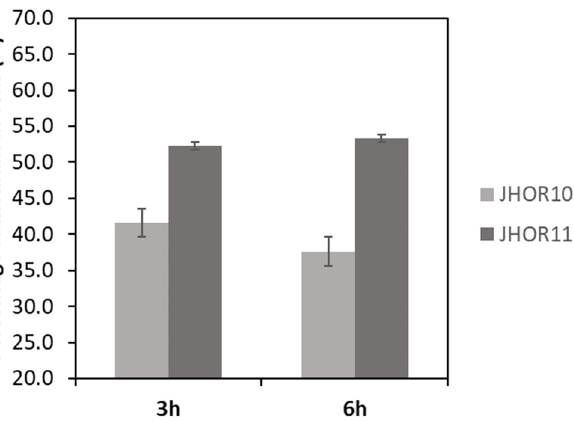
Figure 2. Internalization of JHOR10 and JHOR11 in A2780 cell line. Cells were incubated for 3 h and 6 h in the presence of 10 µ M of each complex and the percentage of Ru within cells analyzed by ICP- AES.